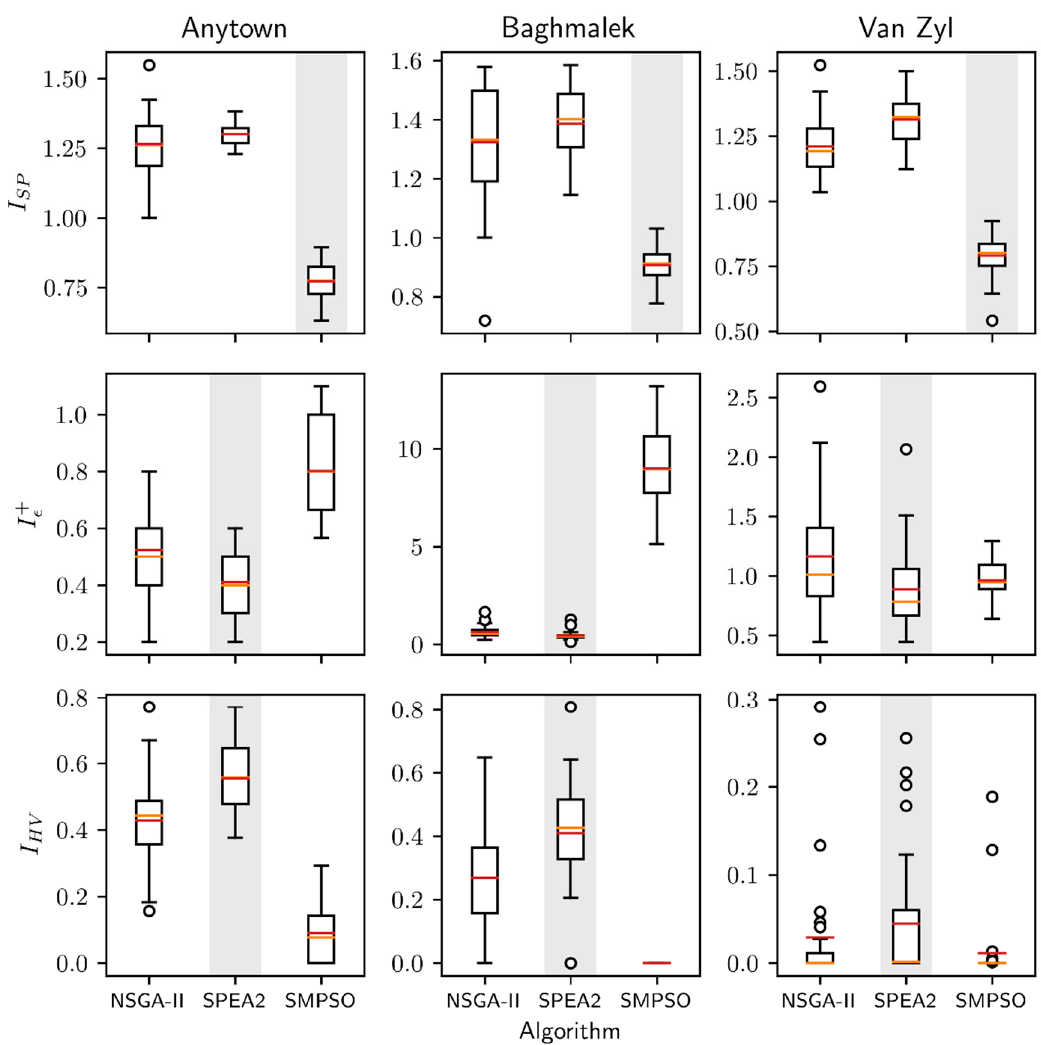
Figure 6. Quality indicators boxplots for the ( left ) Anywotn, ( center ) Baghmalek, and ( right ) Van Zyl network case studies.